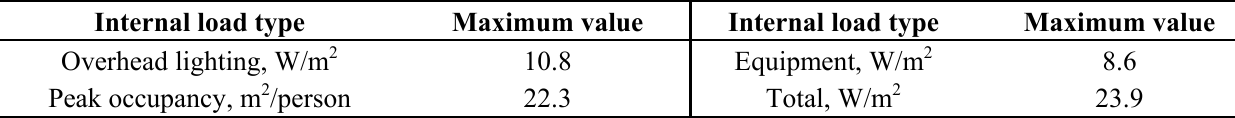
Table 1. Internal load